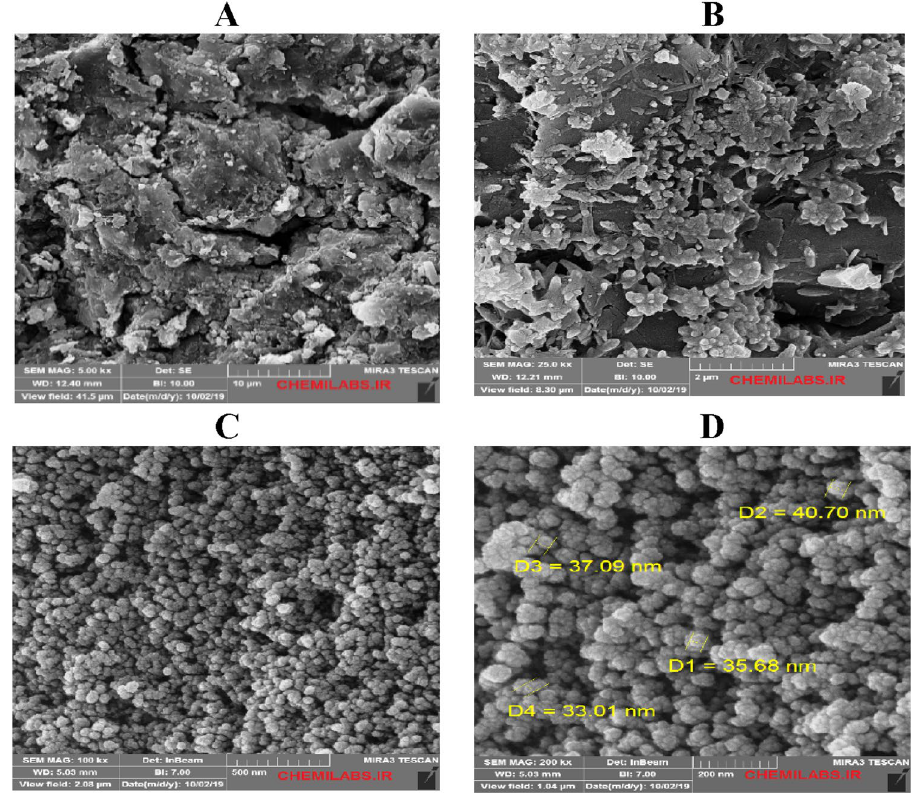
Figure 10. FESEM images analysis of ( A ) a clean sandstone rock (water wet), ( B ) a sandstone rock aged in oil (oil-wet) ( C,D ), and an oil-wet sandstone rock aged in silica